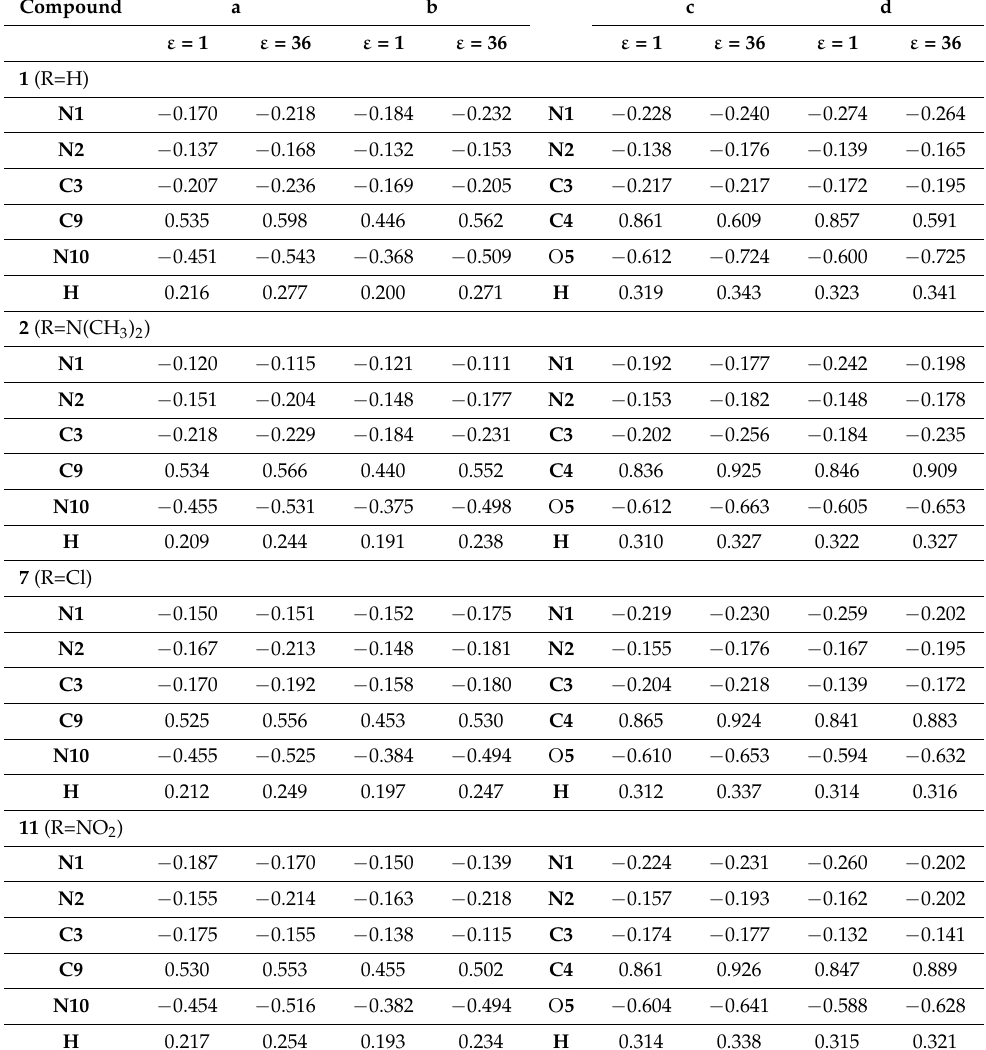
Table 4. Selected CHELPG charges (in e) calculated at M062X/6-31+G(d,p) level of theory for a – d isomers of compounds 1 , 2 , 7 and 11 in the gas phase and in acetonitrile solution. Atom numbering scheme is shown in Figure 1 and Table